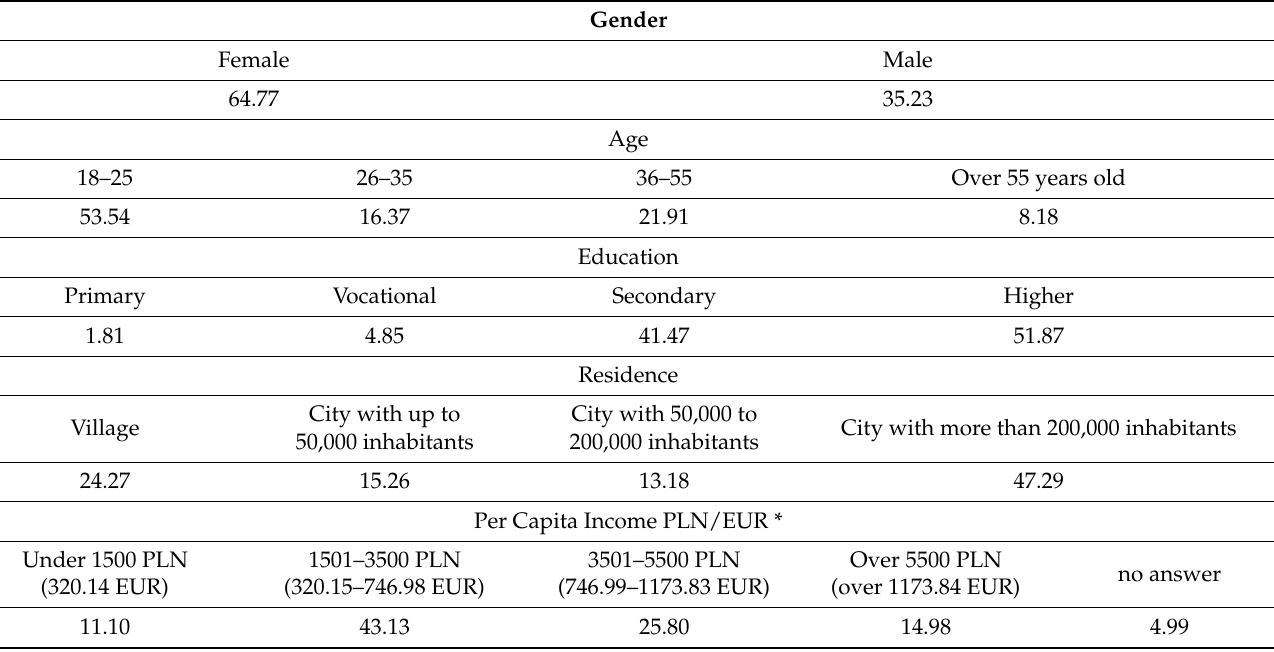
Table 1. Characteristics of the study population (n = 721, data in